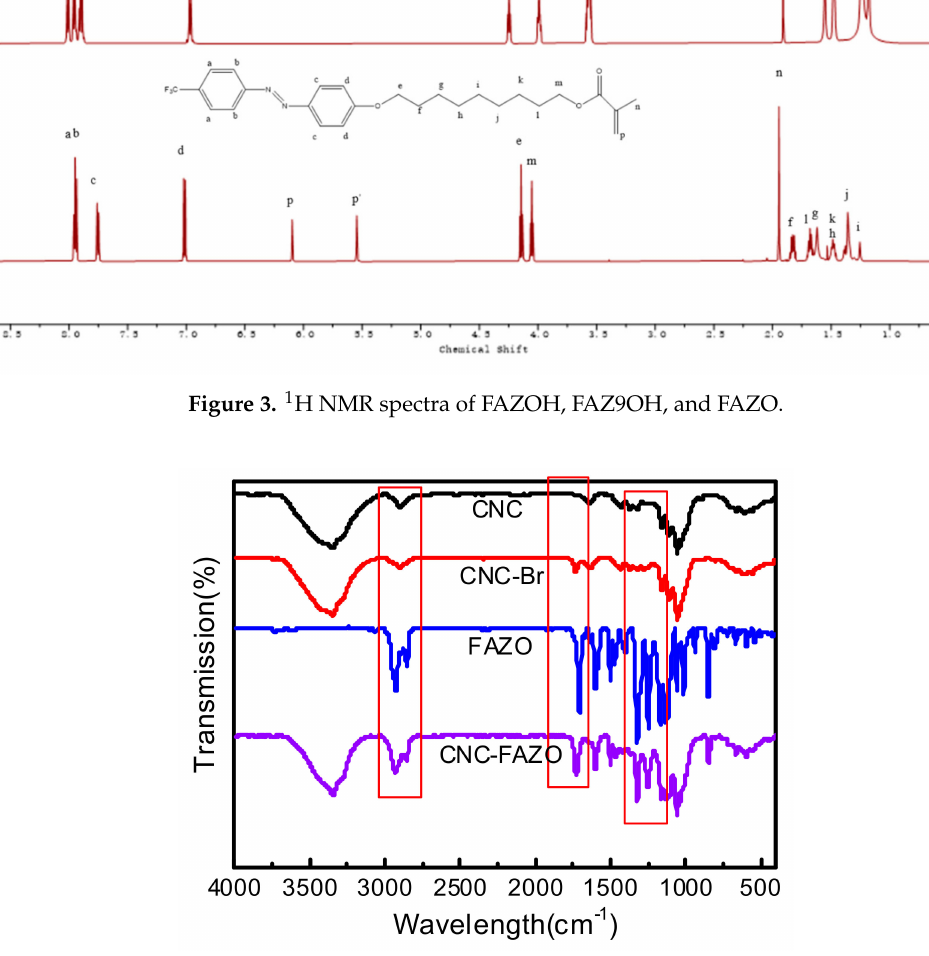
Figure 4. FT-IR spectra of cellulose nanocrystal (CNC), cellulose-based bromide carbonyl-bromide compound (CNC-Br), FAZO, and